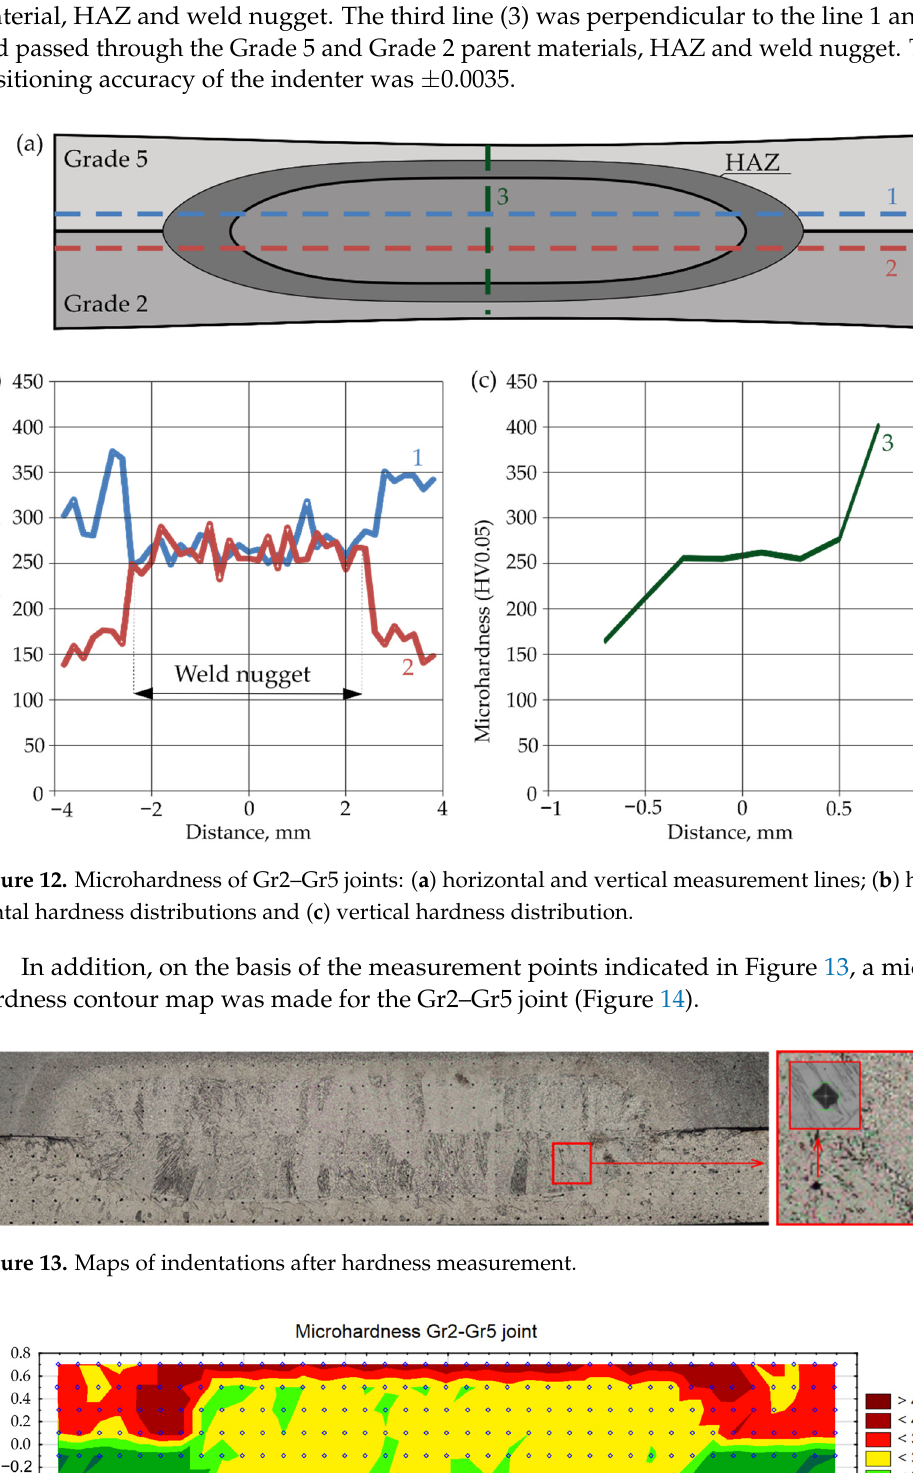
Figure 13. Maps of indentations after hardness measurement.